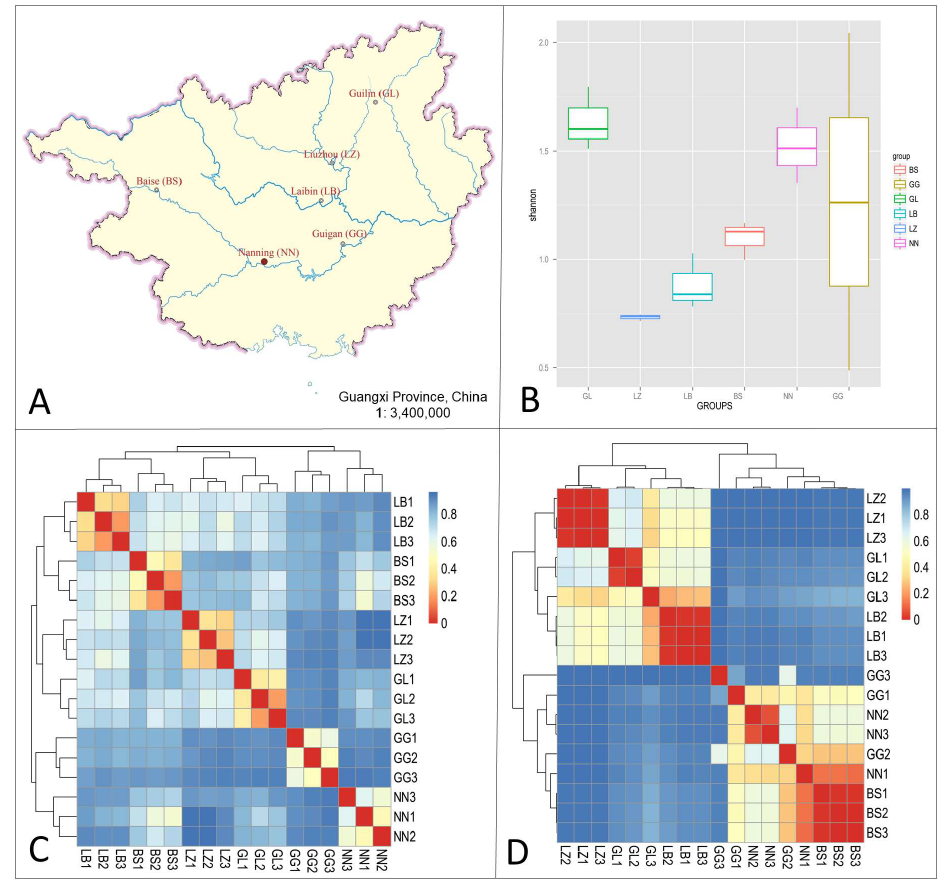
Figure 1. Suansun sampling location and microbial diversity. ( A ) Suansun sampling location distribution. The map came from the Ministry of Natural Resources of the People’s Republic of China, and the approval number is GS (2019)3333. ( B ) Distribution map of diversity Shannon index between groups. ( C ) Community distance heat map by Jaccard. ( D ) Community distance heat map by